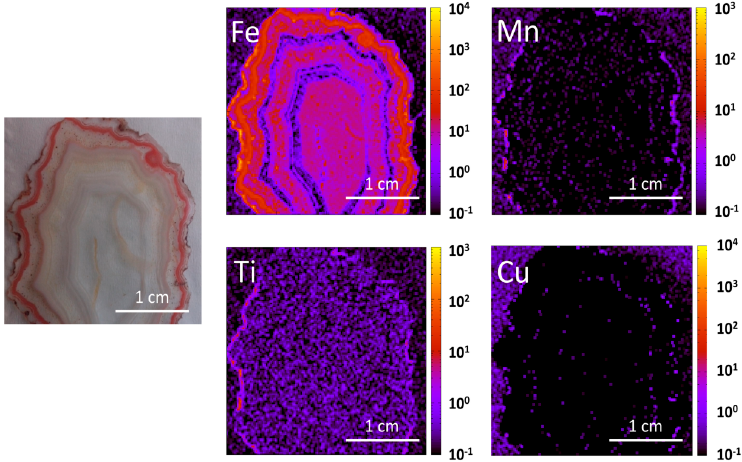
Figure 11. The photo of monocentric agate together with maps of characteristic K α X-ray intensities showing spatial distribution of Fe, Mn, Ti and Cu.